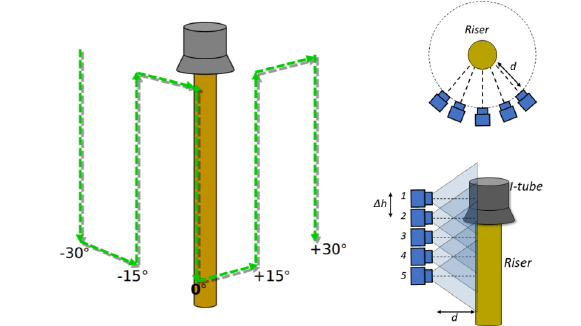
Figure 8. Vertical serpentine with a fixed distance from